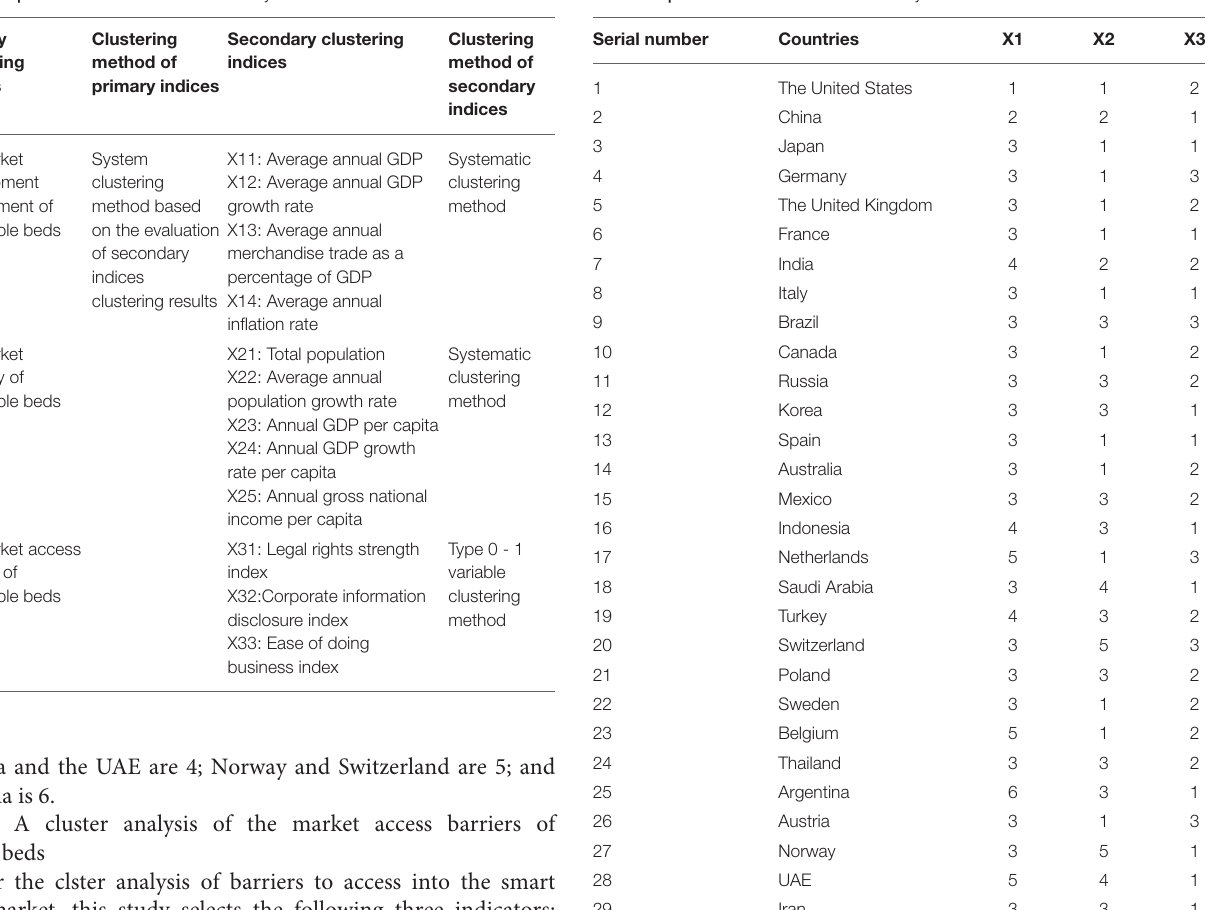
TABLE 2 | Selected indices for cluster